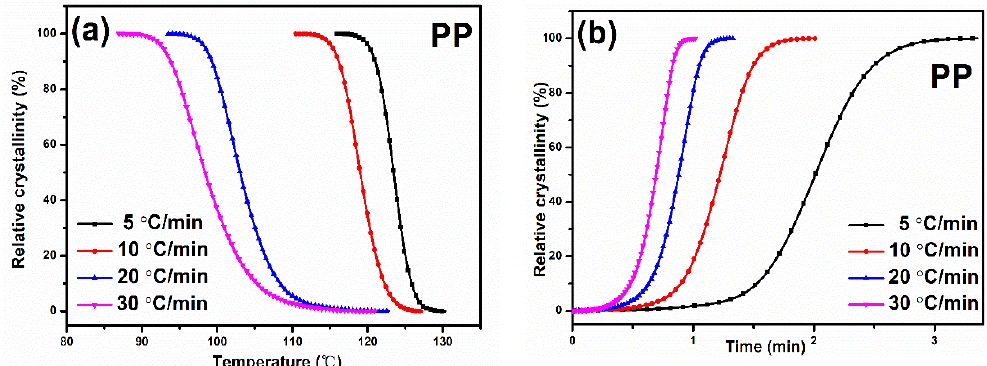
Figure 4. Representative curves of relative crystallinity versus ( a ) temperature and ( b ) time for virgin PP.